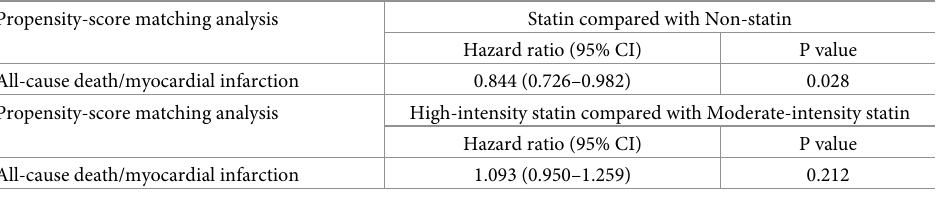
Table 3. Clinical outcomes in patients undergoing percutaneous coronary intervention with drug-eluting stents for angina according to statin